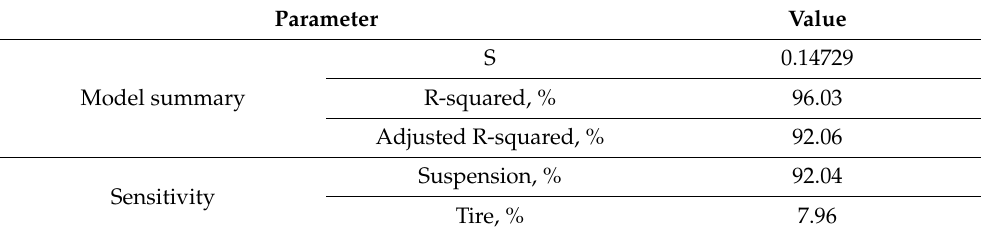
Figure 15. Suspension and tire test results (double-lane change; side-slip angle).